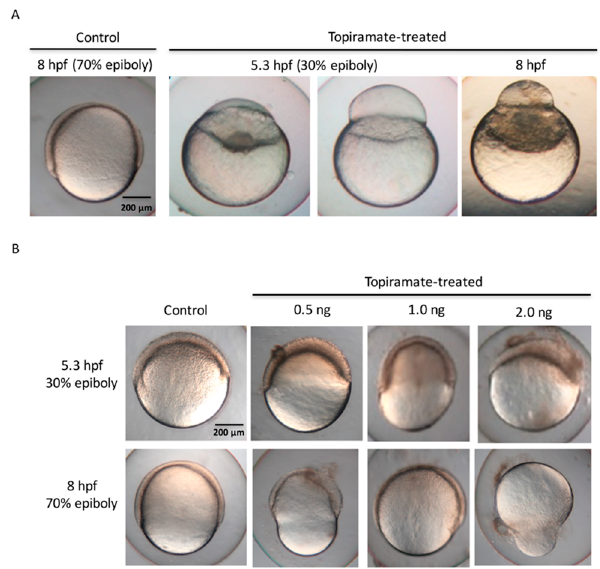
Figure 2. Embryonic epiboly deficiency in topiramate-treated offspring. ( A ) Embryonic development observation from control and topiramate-treated offspring. Morphology at 8 hpf in the control group showed normal epiboly progression. Embryos from topiramate-treated female fish were abnormally expressed during epiboly progression from 5.3 hpf; ( B ) embryonic development observation from control and topiramate-injected embryos at 5.3 and 8 hpf. Scale bar: 200 μ m.